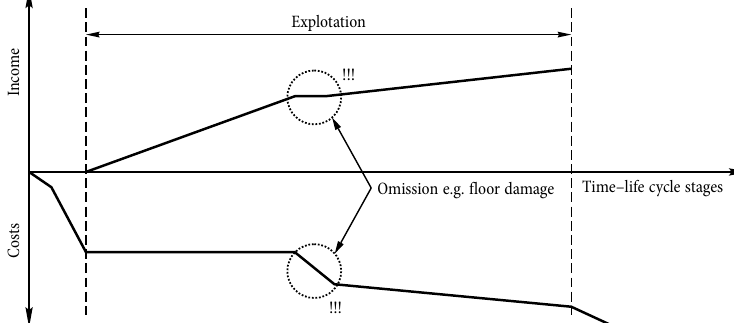
Fig. 2. Diagram chart the distribution of costs and revenues in the event of failure in functioning facility (own study)